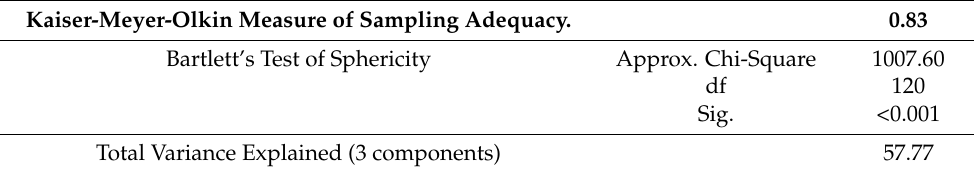
Table 3. Kaiser-Meyer-Olkin and Bartlett’s Test and Total Variance Explained. Kaiser-Meyer-Olkin Measure of Sampling Adequacy.